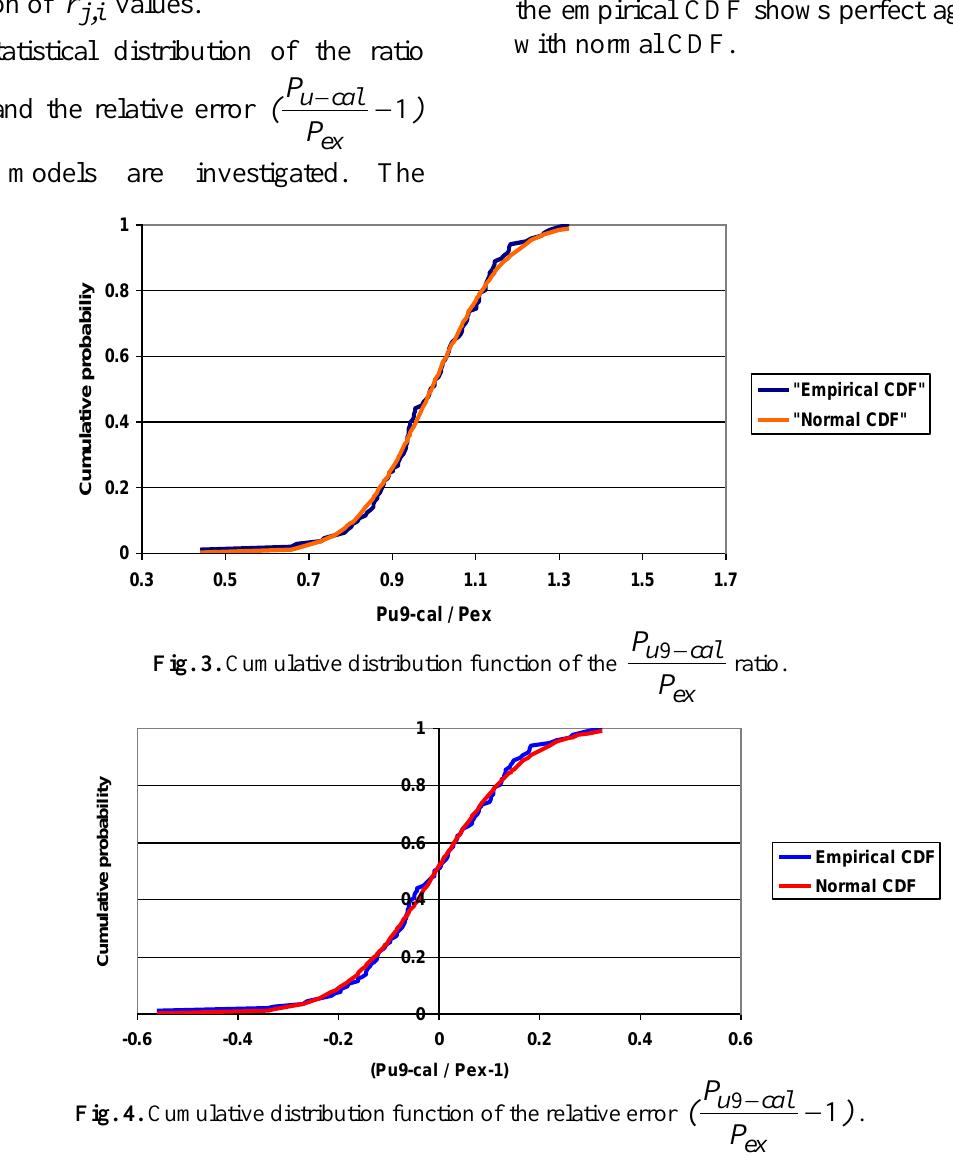
Fig. 4. Cumulative distribution function of the relative